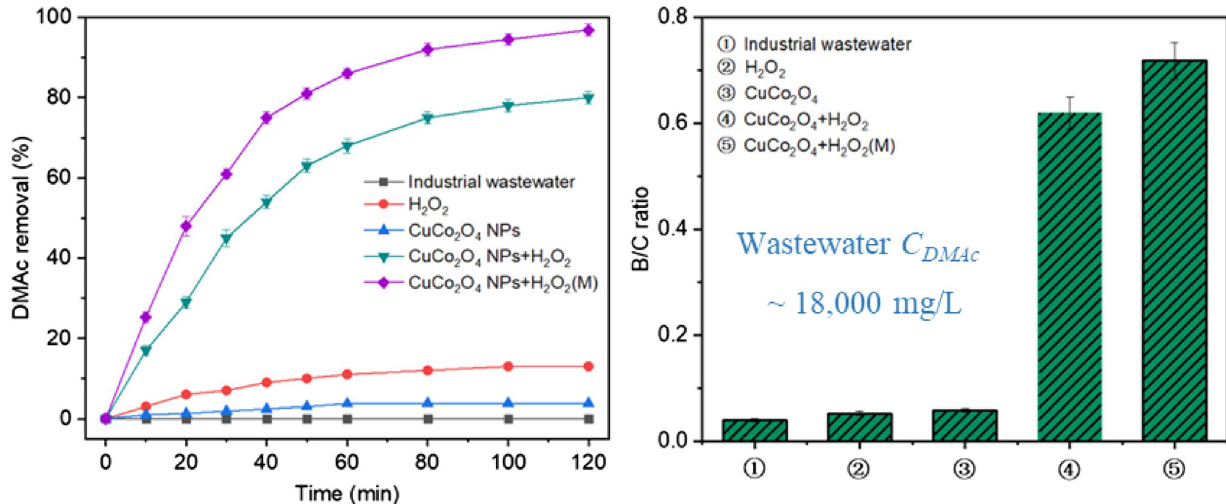
Fig. 9 Industrial wastewater treatment in membrane Fenton-like process: a DMAc removal and b biodegradability with BOD/COD ratio (condi-